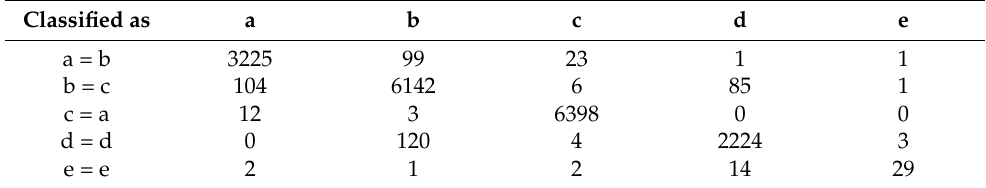
Table A1. The confusion matrix for main propulsion engine fuel oil consumption set as outlet variable.